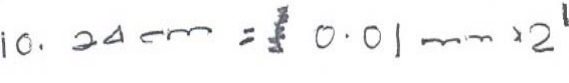
Figure 3: Group 1’s final answer in problem 1 Group 1 went a step further in their solution and were able to grasp a connection to exponents. They achieved an answer of 0, 01 mm × 2 10 . The group